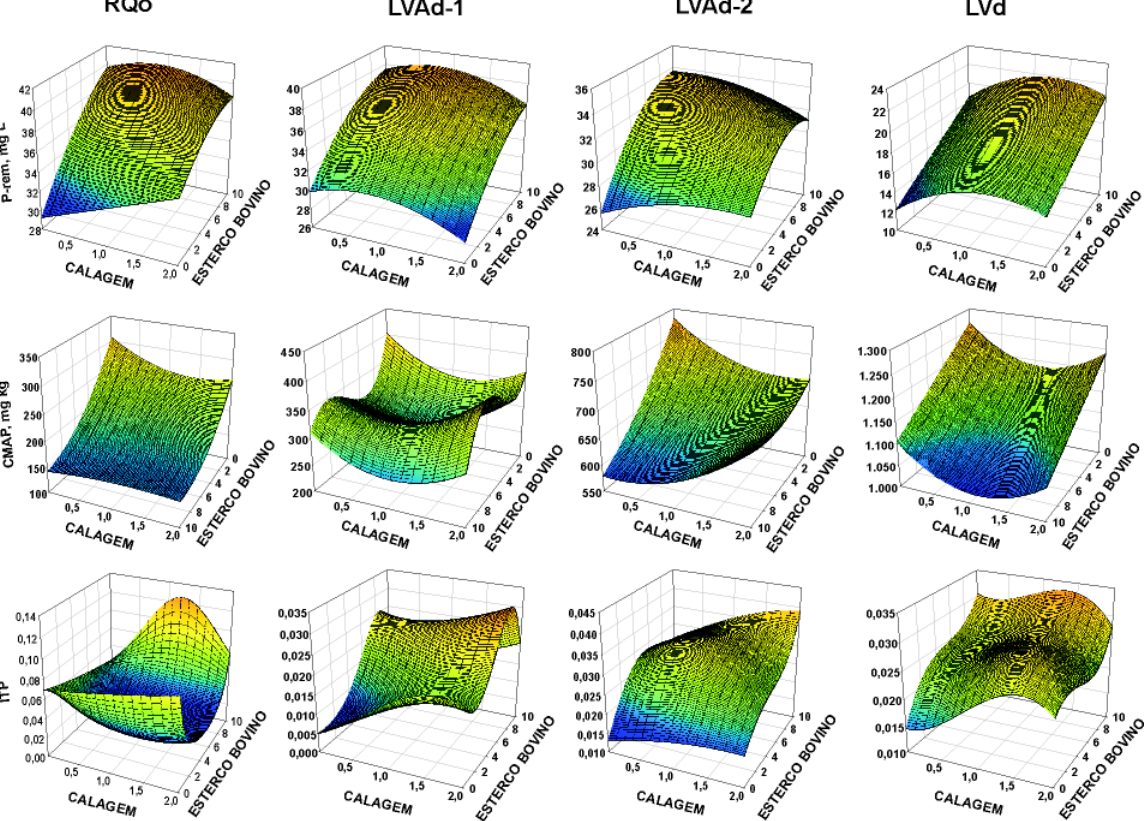
Figura 1. Fósforo remanescente (P-rem), capacidade máxima de adsorção de P (CMAP) e índice tampão de fosfato (ITP), considerando a aplicação de esterco bovino (% do volume de solo) e calagem (vezes a dose para elevar V = 60 Quadro 2. Modelos ajustados com os resultados de fósforo remanescente (P-rem), capacidade máxima de adsorção de fósforo (CMAP) e do índice tampão de fosfato (ITP) considerando a aplicação de esterco bovino (MO) e calcário (CAL), nos solos RQo, LVAd-1, LVAd-2 e LVd